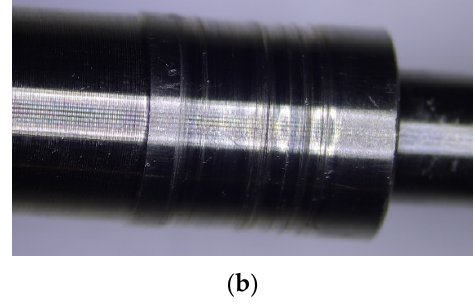
Figure 3. Worn top layers of turbocharger shaft journals: Renault Laguna 1.9 DCI, Garret 708,639 model ( a ), Peugeot 3071.6HDI, Garret 7534200375J6 model ( b ).